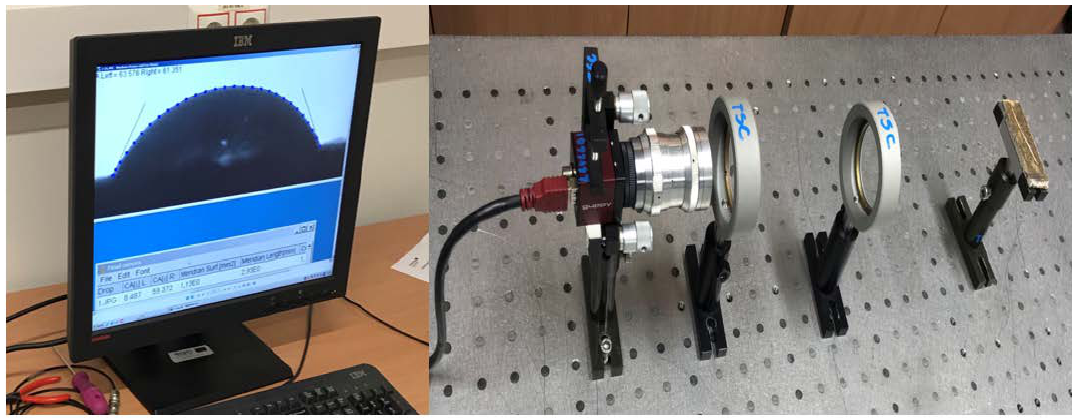
Figure 5. Contact angle measurement apparatus.